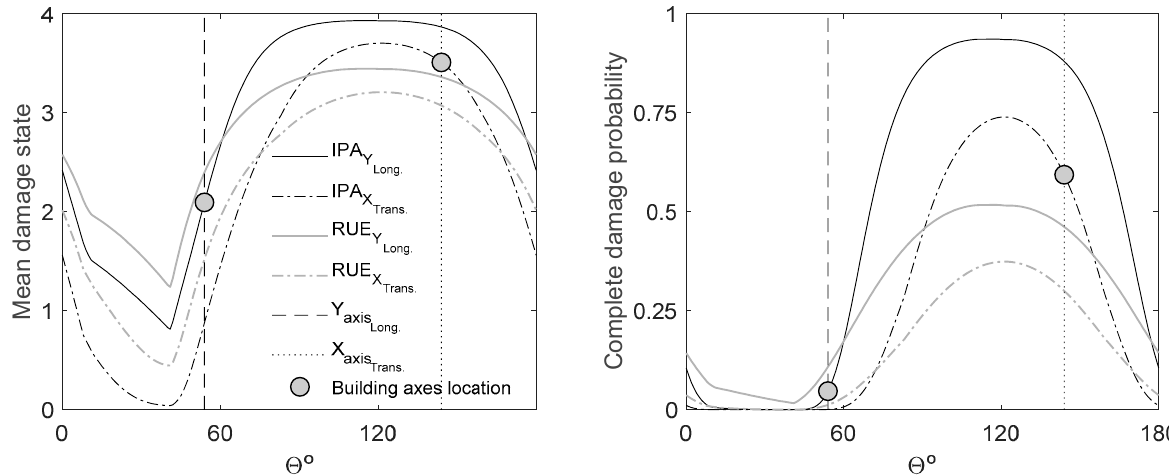
Figure 18. Mean damage state and complete damage probability as a function of the rotation angle of the seismic action. The orientation of the principal axes of the building (54° and 144°) is shown.